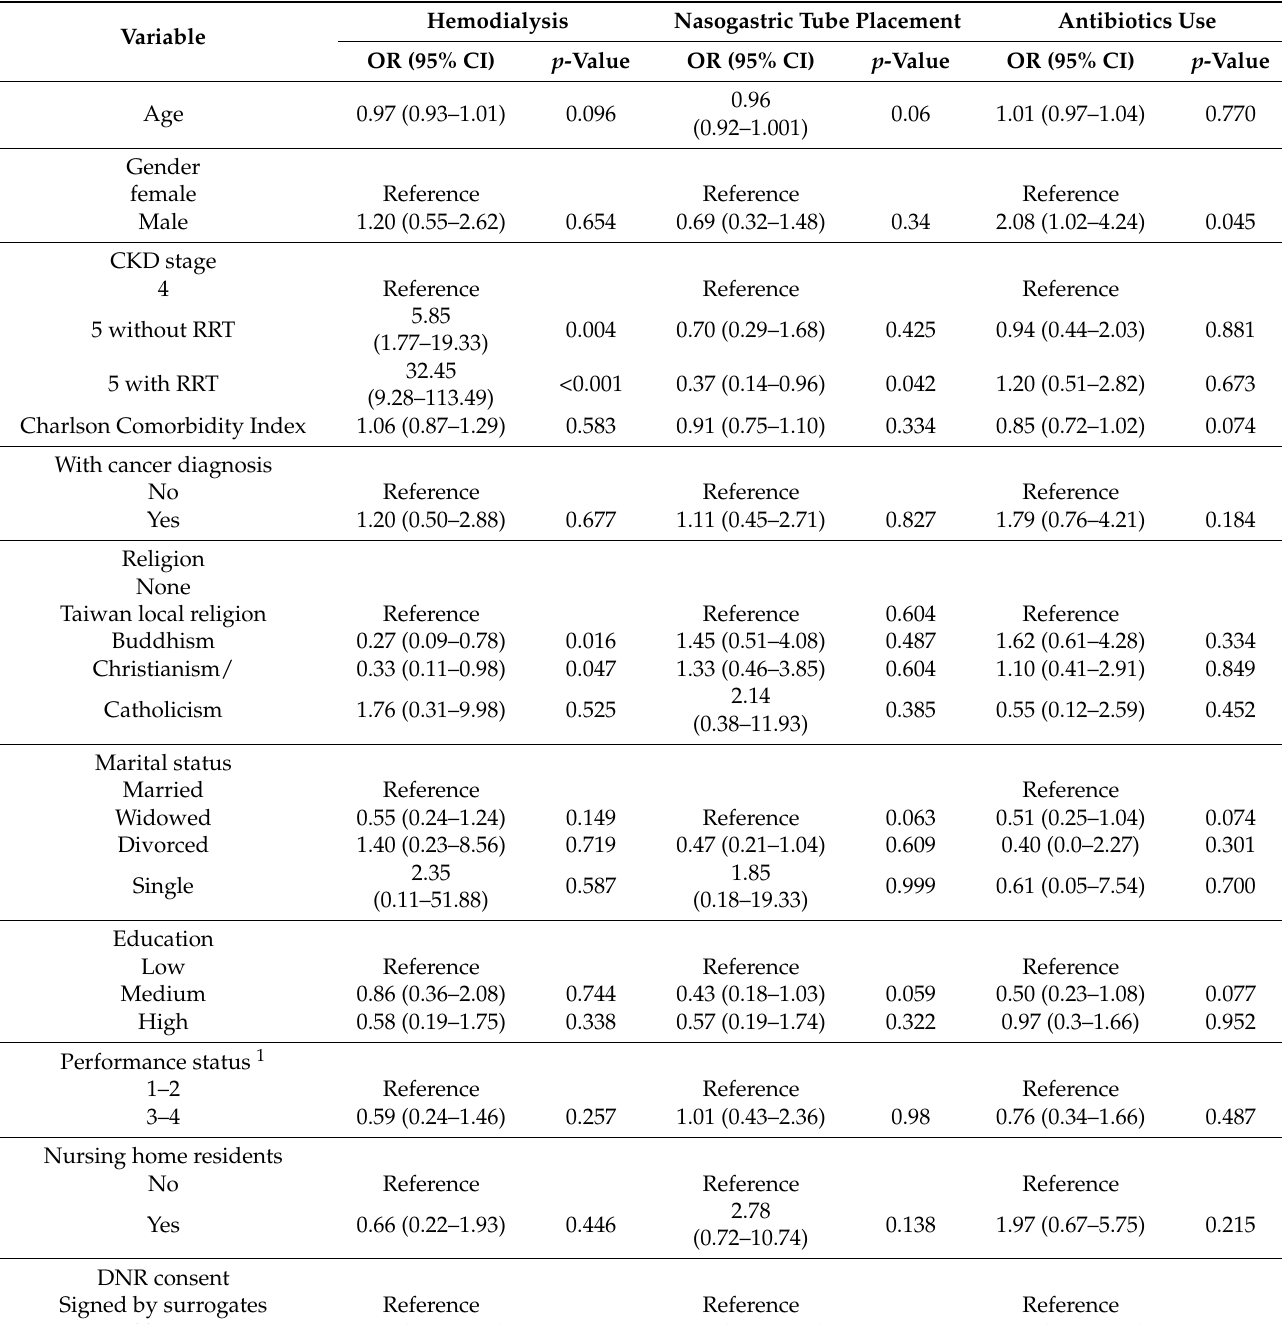
Table 3. Factors related to end-of-life treatments in the final seven days before death in patients with advanced kidney disease.